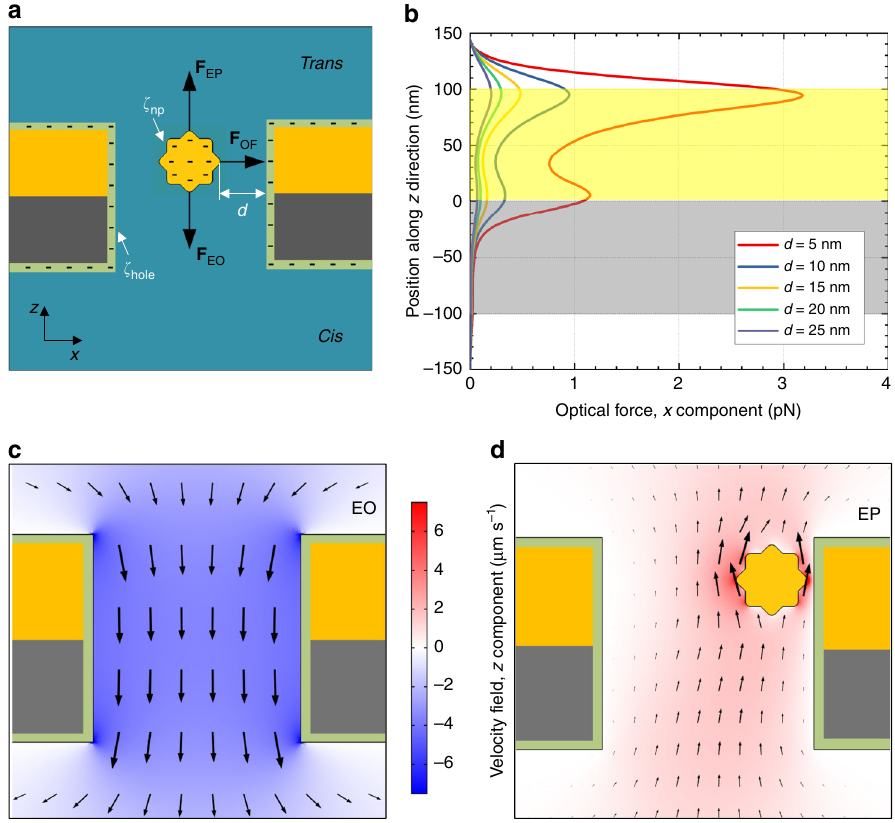
Fig. 2 Electro-plasmonic trapping effect. a Schematic illustration of the electro-plasmonic forces exerted on an AuNU in the nanohole under bias, both of which have negative surface charges. Black arrows represent the directions of electrophoretic ( F EP ), electroosmotic ( F EO ), and optical ( F OF ) forces. White arrows indicate the zeta potentials on the AuNU ( ζ np ) and on the nanohole wall ( ζ hole ), respectively, and d is the distance between the particle tip and nanohole wall. b Simulated optical force under 10-mW laser of 785-nm wavelength for a varying particle position along z direction with different d . c Simulated electroosmotic (EO) velocity fi eld distribution, z component. d Simulated electrophoretic (EP) velocity fi eld distributions, z component. Color bar represents the positive (red) and negative (blue) velocity in ( c , d